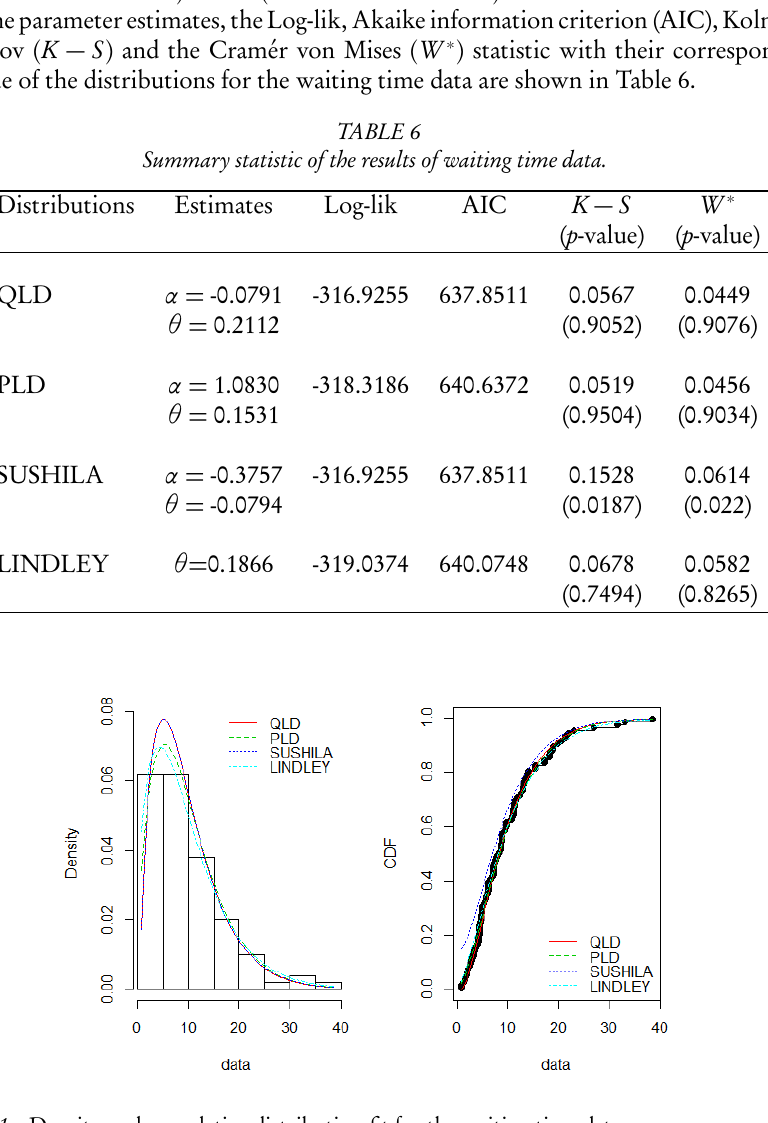
Figure 1 – Density and cumulative distribution fit for the waiting time